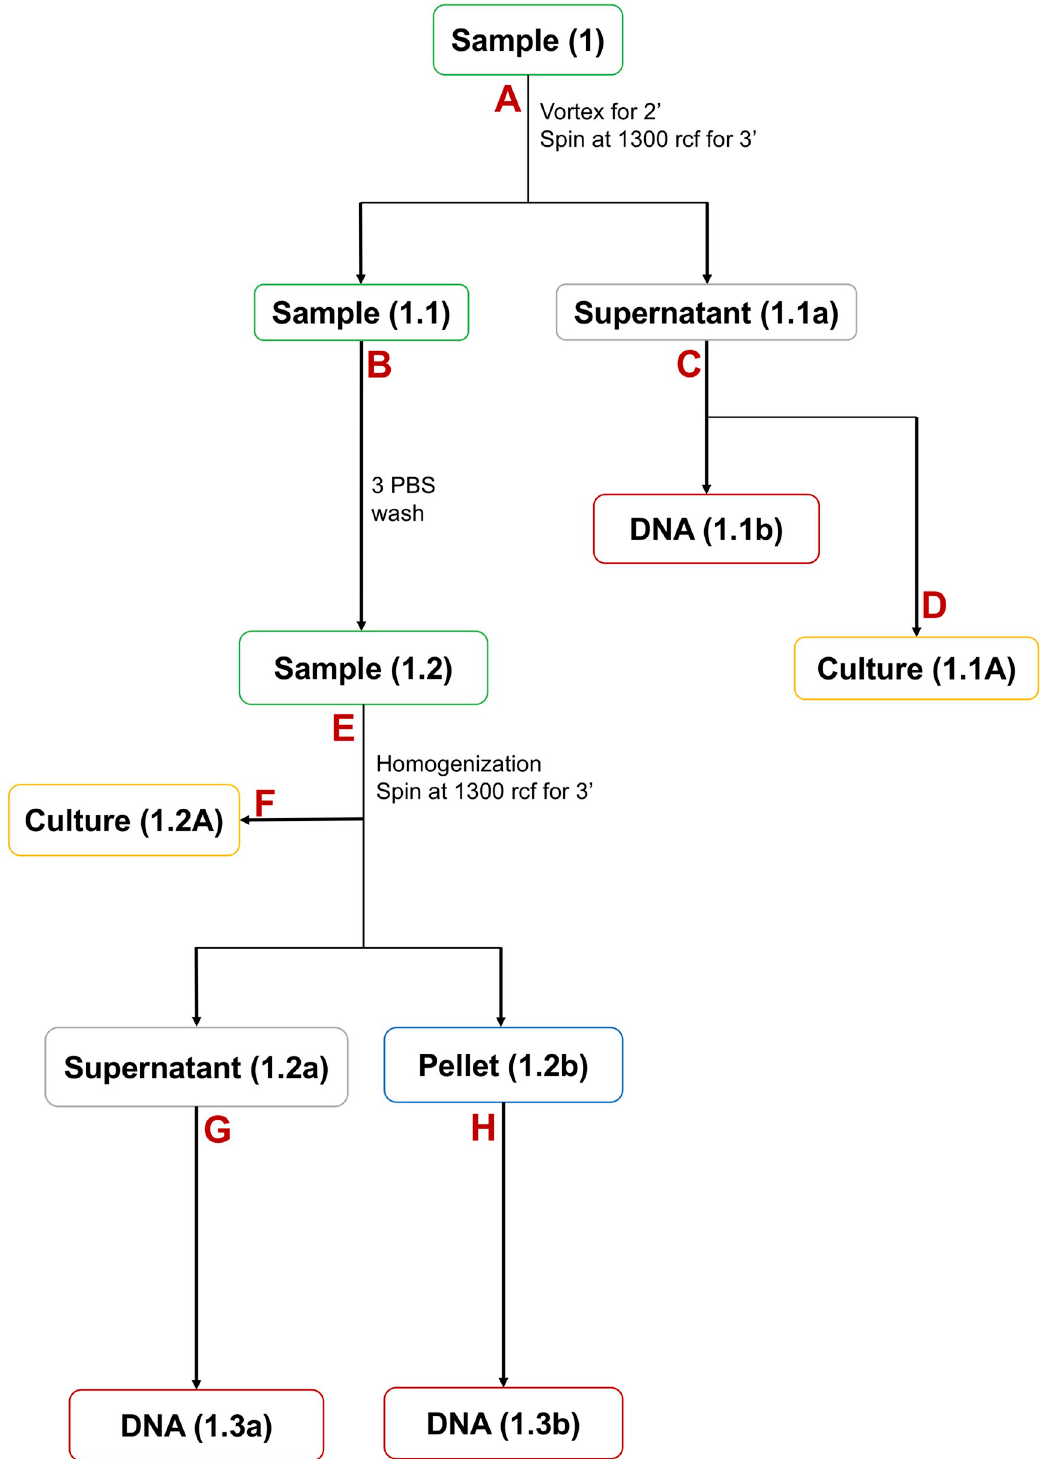
Fig 9. Work flow description of bacterial culture and DNA isolation from biopsies. (A) In this step biopsies taken in PBS were vortexed and centrifuged at 1300 rcf for 3 min to remove environmental contaminant from the biopsy. ( B) Biopsies were washed thrice with PBS to remove all possible environmental contaminant. (C) DNA were isolated from supernatant (1 st washed PBS). (D) Supernatant (1 st washed PBS) were cultured on BHI plates for environmental contaminants. (E) 3 washed biopsies were